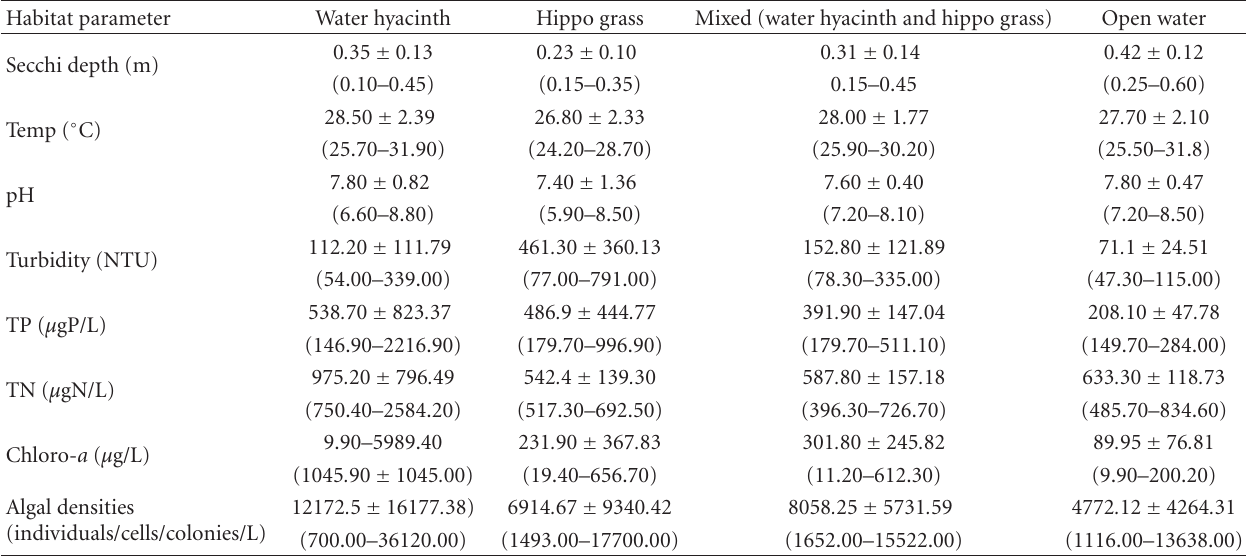
Table 1: Variations (Mean ± SD) in the physicochemical parameters between the habitats of water hyacinth complex. Values in parenthesis indicate the